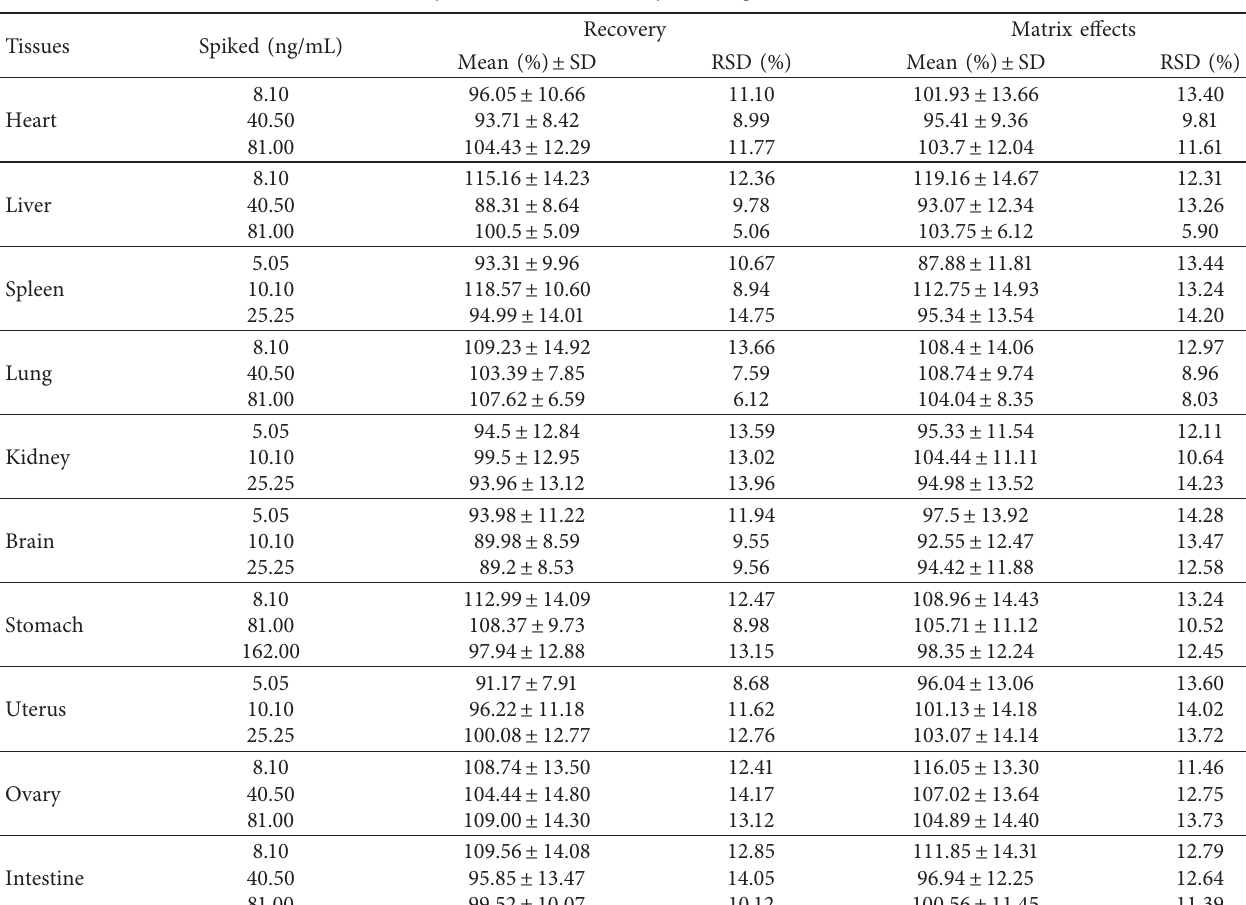
Table 12: Recovery and matrix effect study of astragalin in rat tissues ( n �